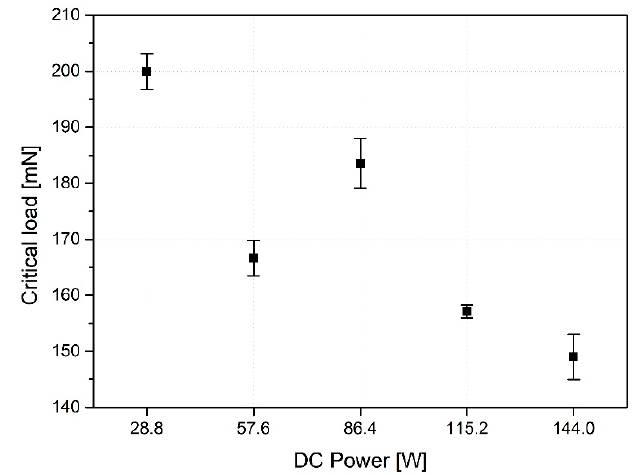
Figure 7. The results of critical load by nano-scratch test [ mN ].